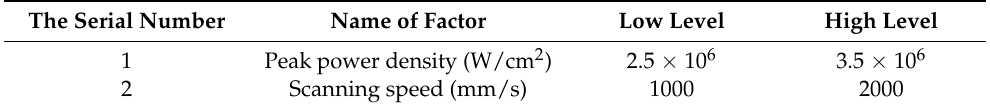
Table 2. Horizontal settings of experiment factors.